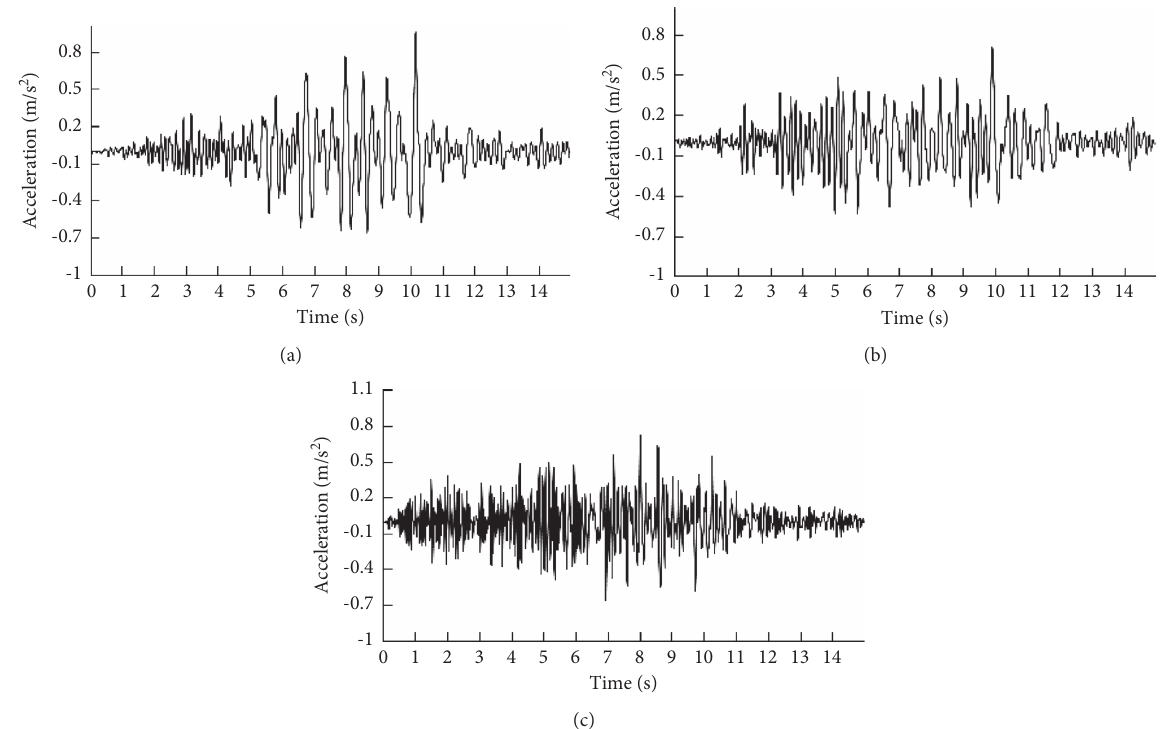
Figure 5: Acceleration curve. (a) x direction, (b) y direction, and (c) z